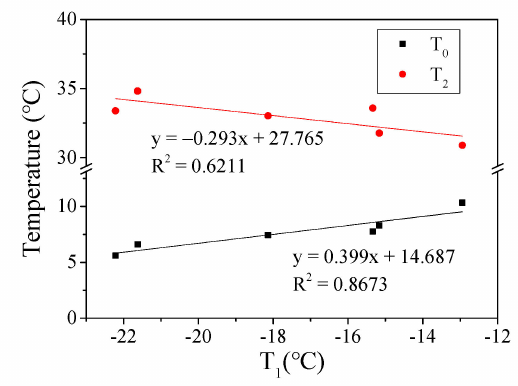
Figure 6. Relationship between T 1 and T 0 and T 2 .